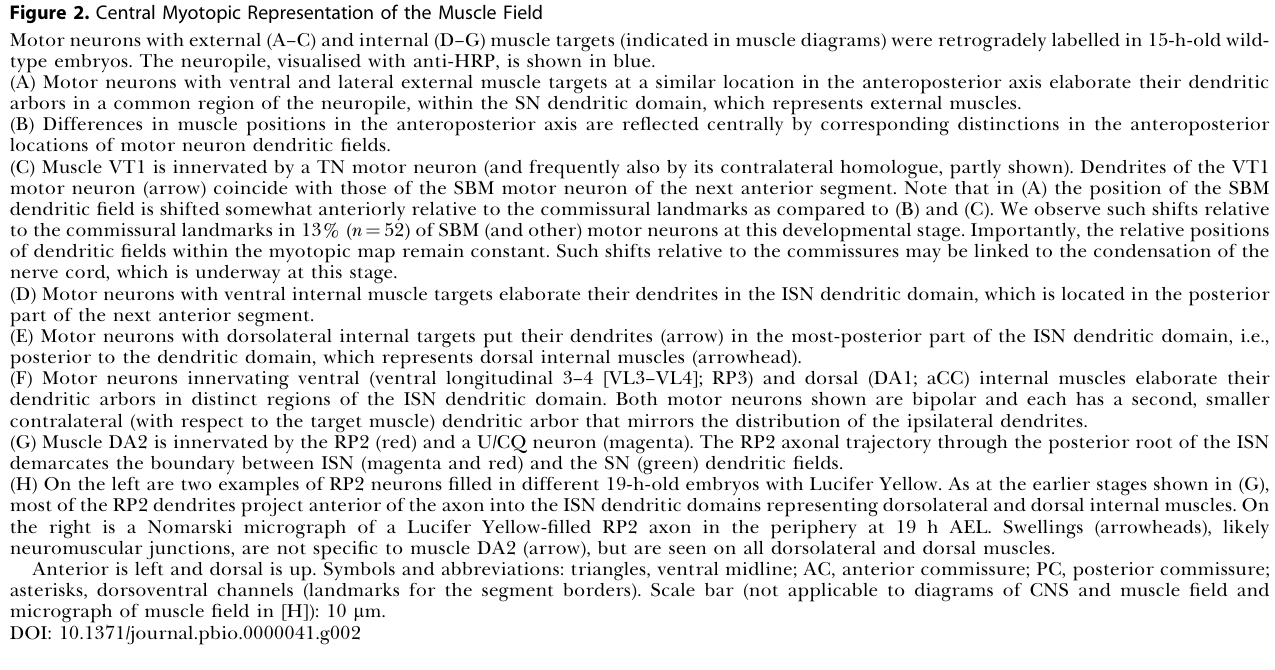
PLoS Biology | http://biology.plosjournals.org Volume 1 | Issue 2 | Page